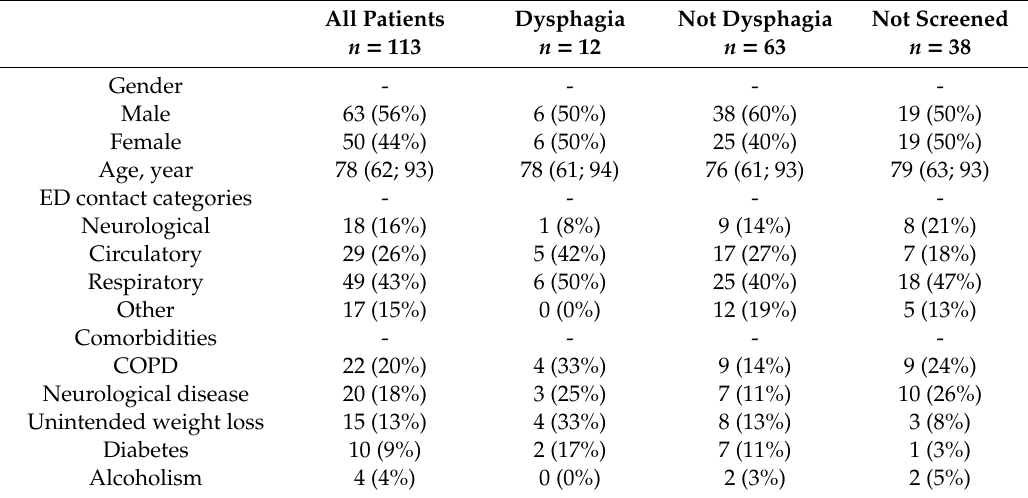
Table 1. Demographical and clinical characteristics of